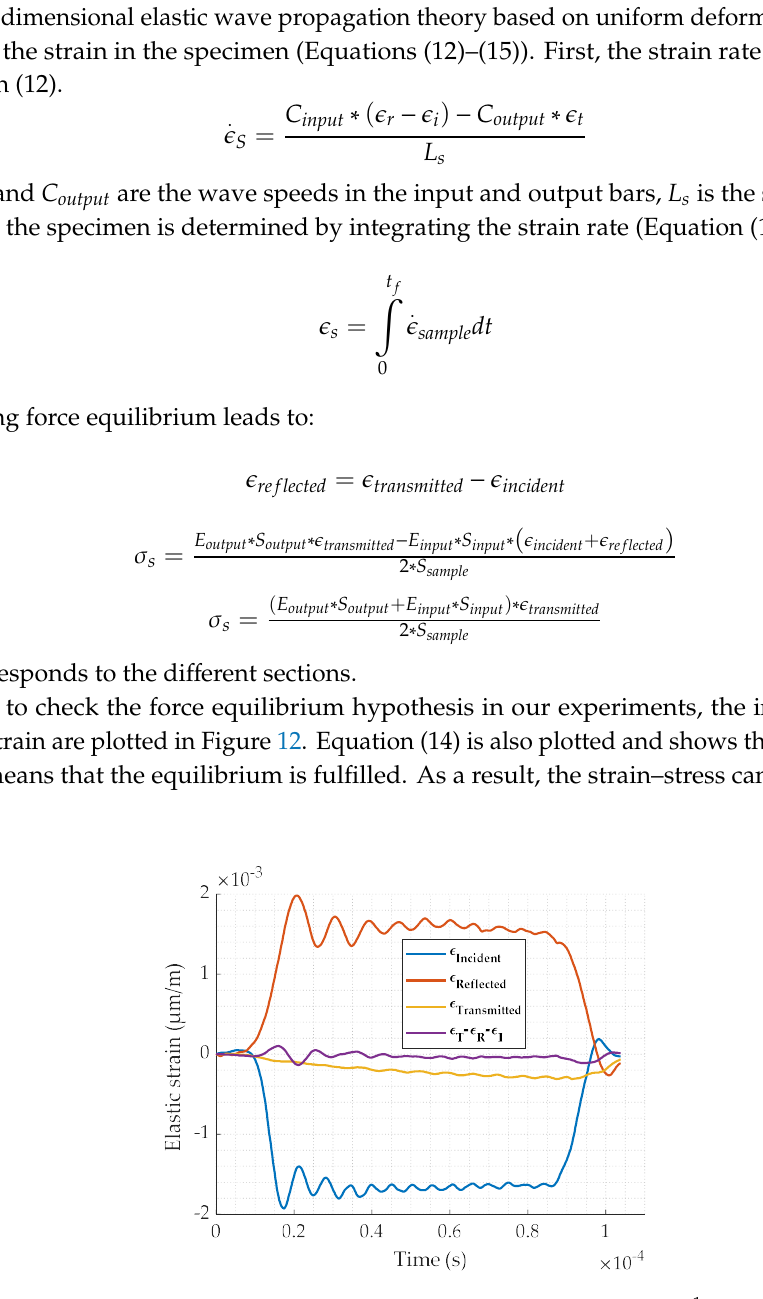
Figure 12. Waves equilibrium verification for test at 1850 s −1 .